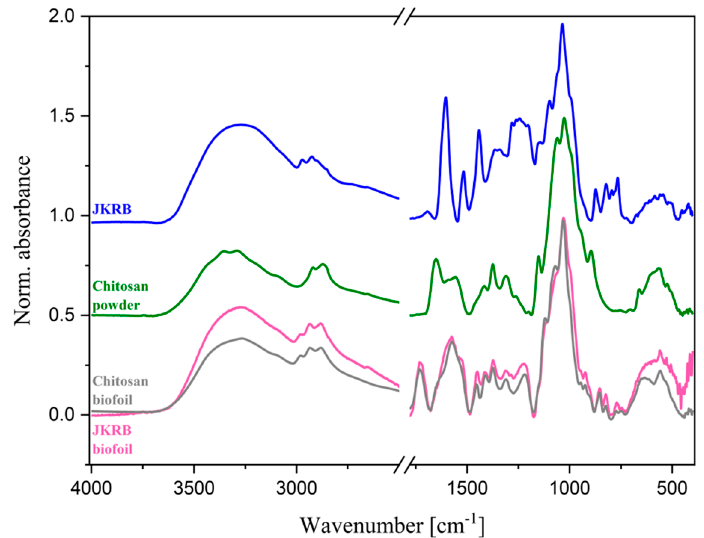
Figure 7. ATR ‐ FTIR spectra of JKRB, chitosan powder, and chitosan (blank) and JKRB biofoils.